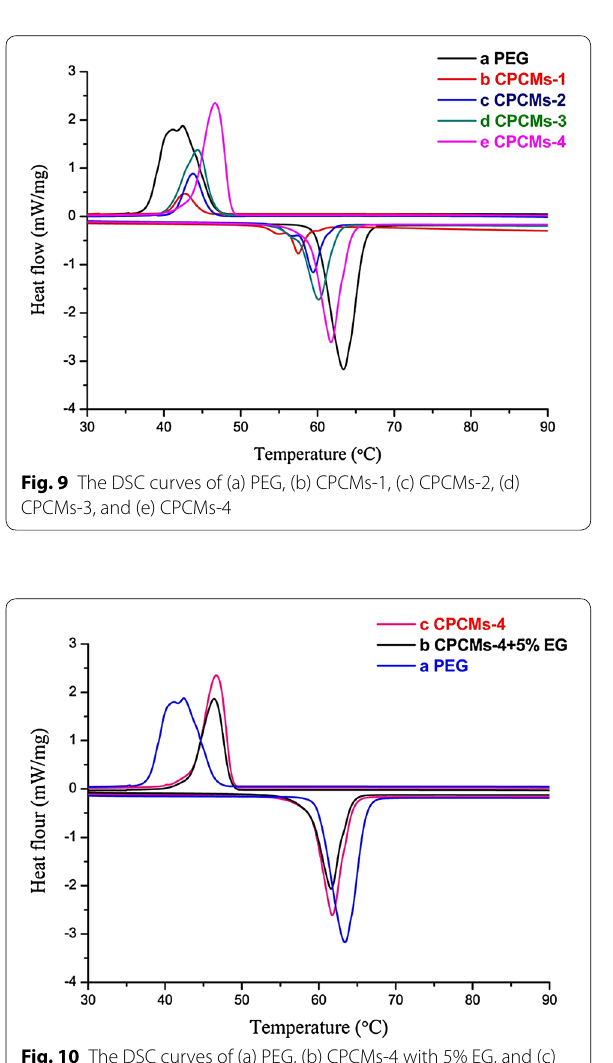
, CPCMs-4 with 1% EG, 1